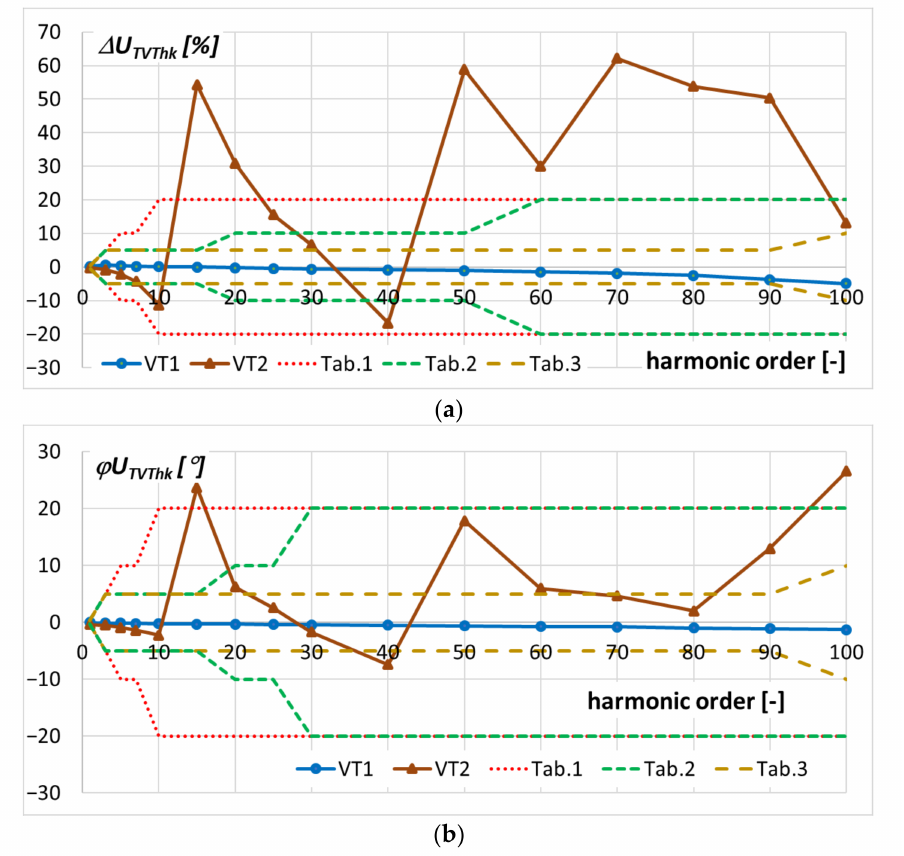
√ 3) kV: ( a ) voltage error,